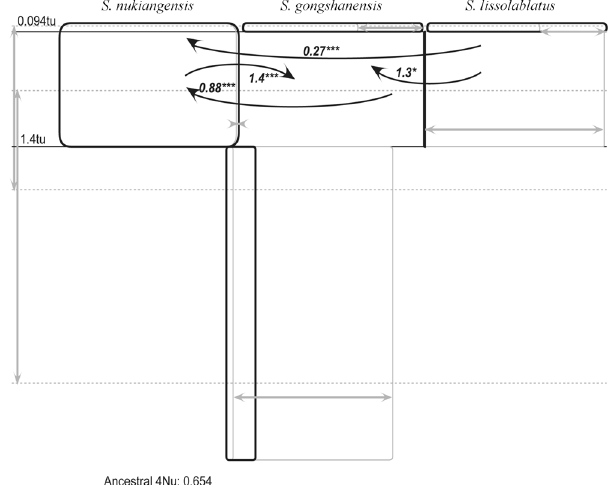
Figure 4. Isolation with migration analyses for the three Schizothorax species based on Cytb . The arrows represent migration directions from the source population to the receiving population; the numbers next to arrows are 2NM values. Only statistically significant cases of gene flow are presented. * P < 0.05 and *** P < 0.001.